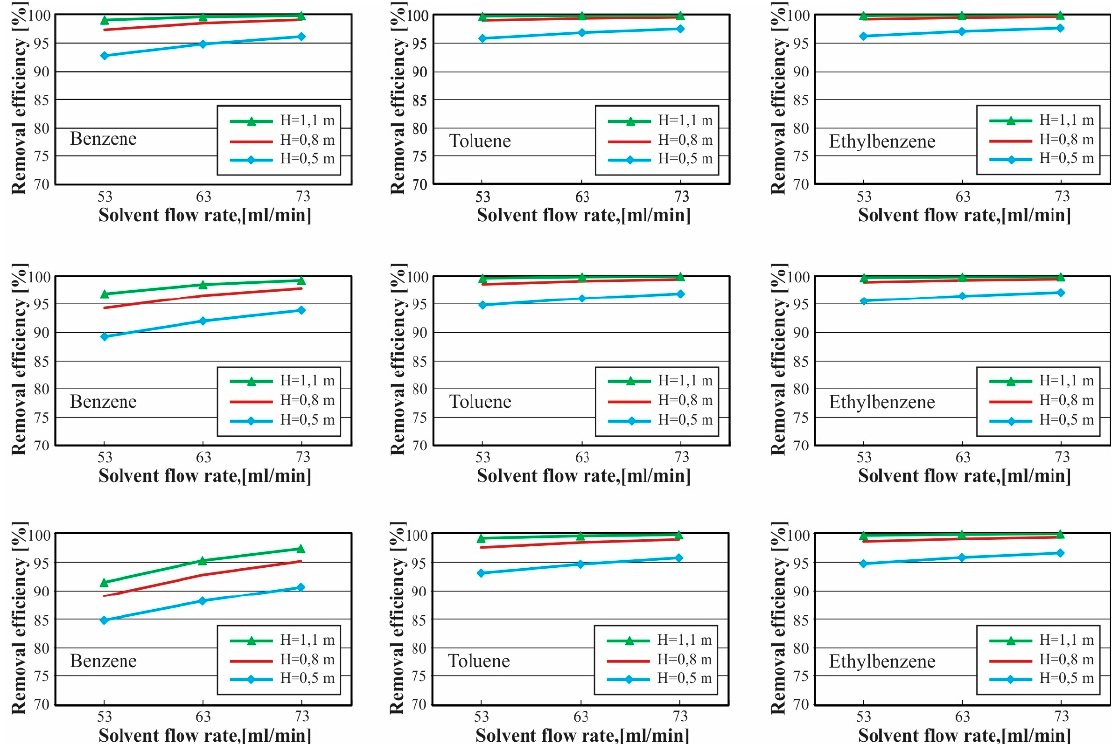
Figure 10. Effect of bed height on the removal efficiency of tar components at solvent volumetric flow Figure 10. E ff ect of bed height on the removal e ffi ciency of tar components at solvent volumetric flow rates of 53.63 and 73mL/min, the temperatures are 30 °C (above), 40 °C (middle), and 50 °C (below). rates of 53.63 and 73mL / min, the temperatures are 30 ◦ C ( above ), 40 ◦ C ( middle ), and 50 ◦ C ( below